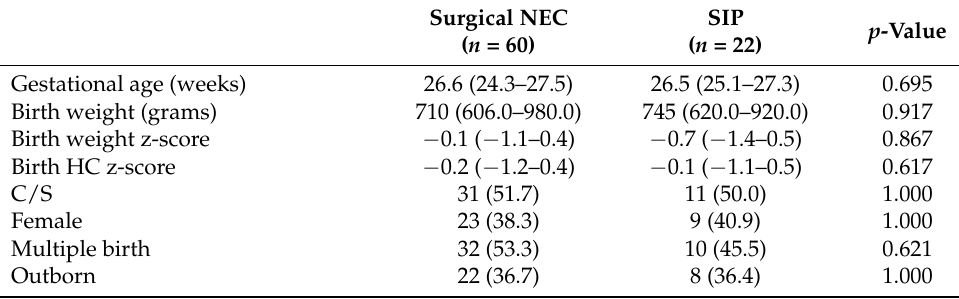
Table 1. Perinatal and neonatal characteristics of the study